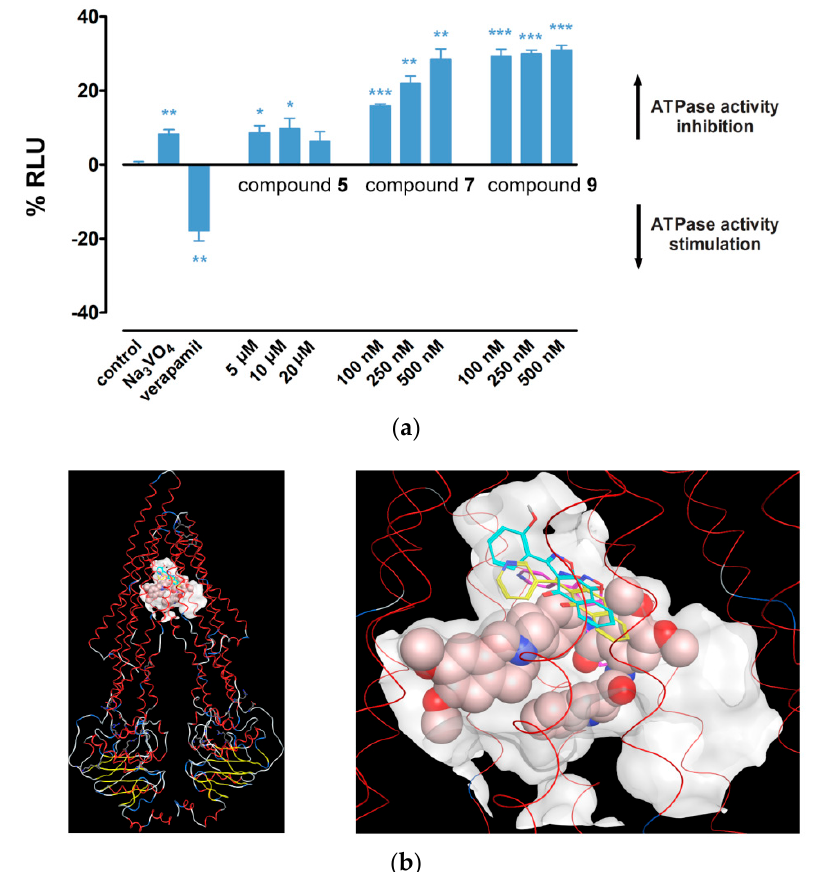
Figure 5. Hsp90 inhibitors affect the ATPase activity of P-gp by direct binding in the P-gp cavity. ( a ) Changes in P-gp ATPase activity after treatment with Hsp90 inhibitors. The y-axis represents percentage of change in relative luminescence units (RLU). Control is normalized to zero. Na 3 VO 4 and verapamil are included as positive controls. The results are expressed as mean ± SEM. Statistical significance: p < 0.05 (*), p < 0.01 (**), p < 0.001 (***). ( b ) Binding poses of compound 5 (C atoms in cyan), compound 7 (C atoms in magenta), compound 9 (C atoms in yellow), and the positive control tariquidar (space filled atoms representation) in the P-gp cavity. The protein backbone is rendered as a line ribbon, and the helices are colored red. The binding site is outlined by the molecular surfaces of the X-ray structures of taxol and two zosuquidar molecules. Both general (left) and close-up views (right) of the binding site are presented.